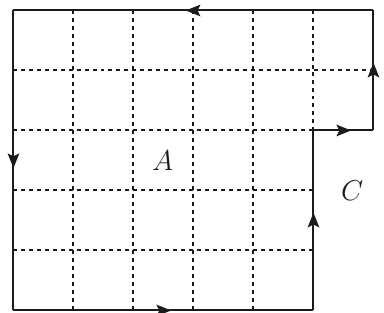
Figure 13 . An example of the region A , which has a boundary C = @A . The K-functional for this region is de(cid:12)ned by integrating out the link variables represented by the dashed lines. The result depends on (cid:0) de(cid:12)ned by (A.3) for the loop C represented by the solid line with